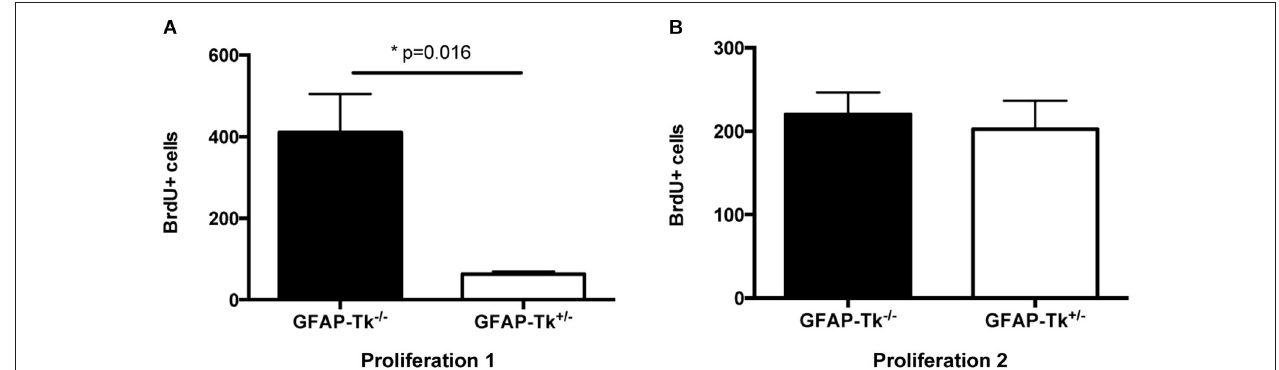
Proliferation 2. Cell proliferation measured by BrdU is not affected 7 days following cessation of VGCV treatment in GFAP-Tk + / − mice (BrdU injected P42 and P43, assessed P43; GFAP-Tk − / − n = 3, GFAP-Tk + / − n = 3). Bars represent mean ±